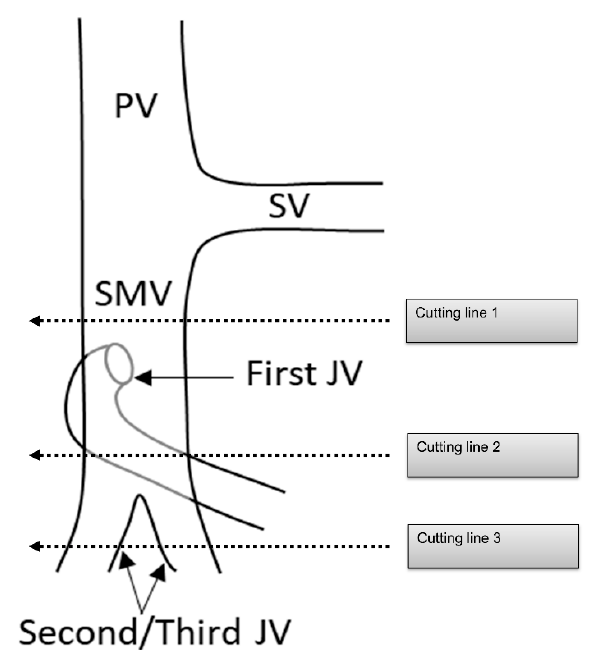
Figure 6. Cutting line for portal vein, superior mesenteric vein, and jejunal vein resection. PV: portal vein; SV: splenic vein; SMV: superior mesenteric vein; JV: jejunal vein.